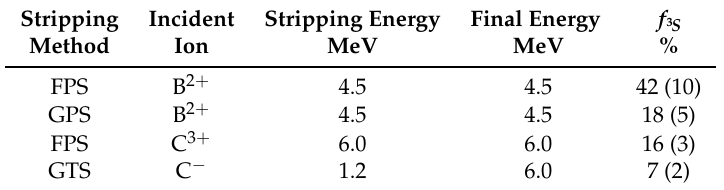
Figure 2. Auger KLL spectra obtained in collisions of 4.5 MeV B 3 + with H 2 , as reported in Ref. [64], and of 6.0 MeV C 4 + with He. The B 3 + and C 4 + beams were produced: [Red squares] After post-stripping the incident B 2 + and C 3 + beams in thin carbon foils (FPS). [Blue dots] After post-stripping the incident B 2 + beam in Ar gas (GPS). [Green triangles] after stripping the incident C − beam in the accelerator terminal in N 2 gas (GTS). A smaller ratio of 4 P to 2 D yields implies a smaller metastable fraction. Table 2. Results of the experimental determination (using Equation (1)) of the 1 s 2 s 3 S metastable fraction f 3 S on target. FPS: foil post-stripping, GPS: gas post-stripping, GTS: gas terminal stripping. The uncertainties of the fractions are given in the adjacent